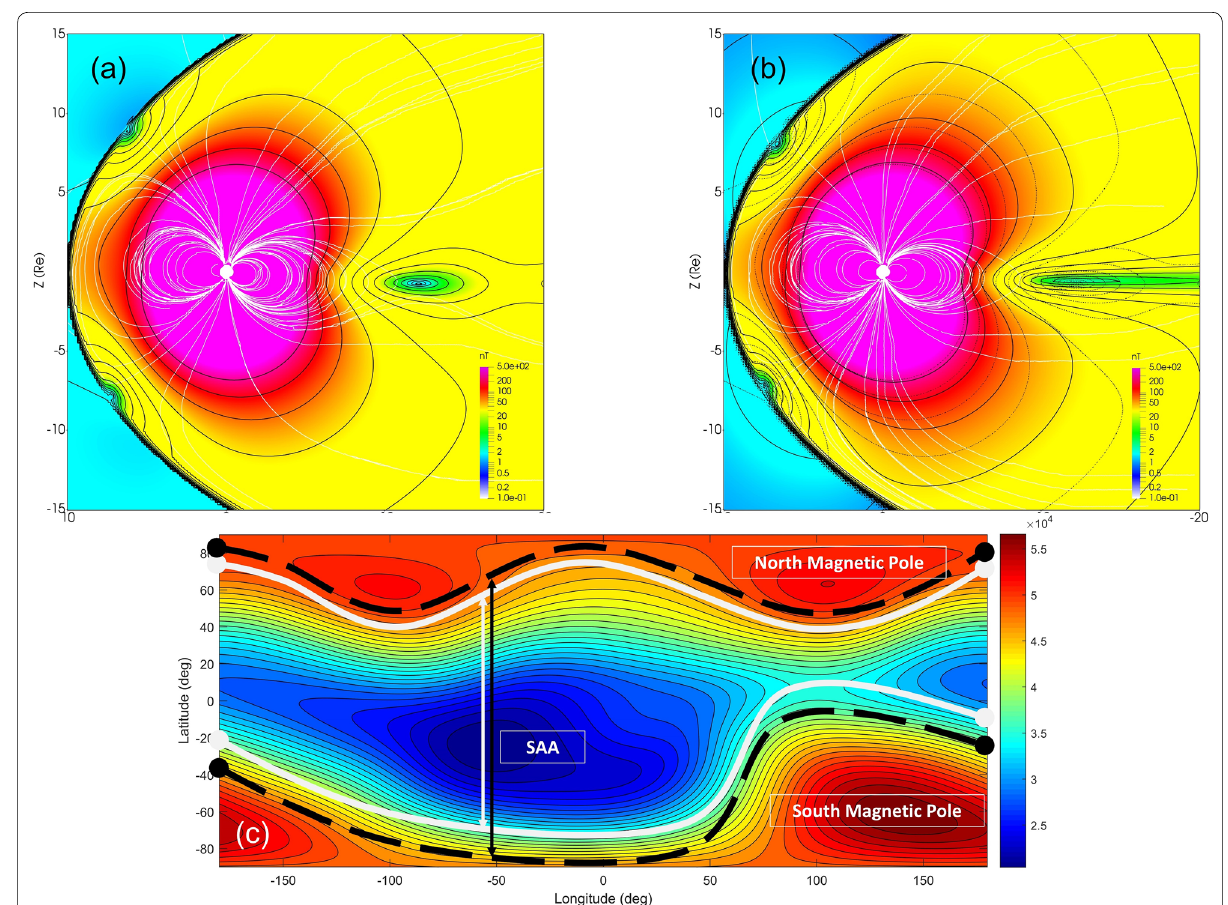
Fig. 9 Dst index effect. The figure shows the Dst index effect on the magnetic poles and on the SAA. a , b show the contour plots of the magnetic strength (black lines) and the field lines (white lines) for the two Dst index cases, corresponds to the contour mapping of the magnetic strength, according to b , where the white lines represent the initial position of the magnetic pole boundaries and the dotted black lines, the variations of the magnetic pole boundaries. Note: the contour lines and the colors are plotted according to the logarithmic